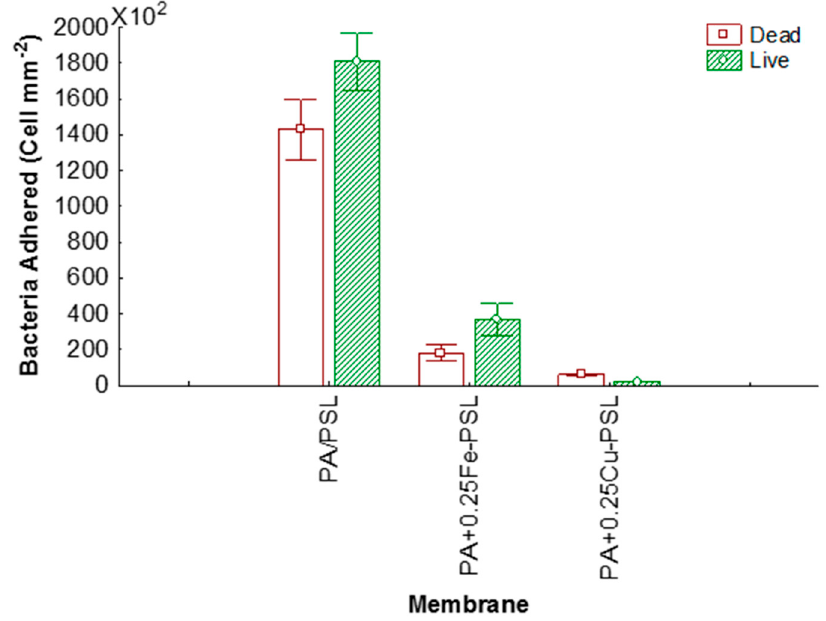
Figure 7. Cells of E. coli per area of the membranes.